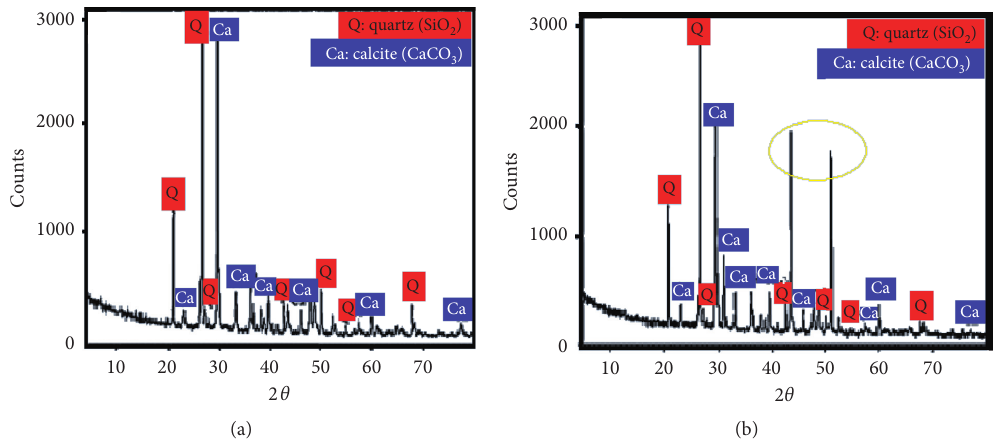
Figure 3: Diffractometric analysis of (a) natural sand and (b) loaded sand.